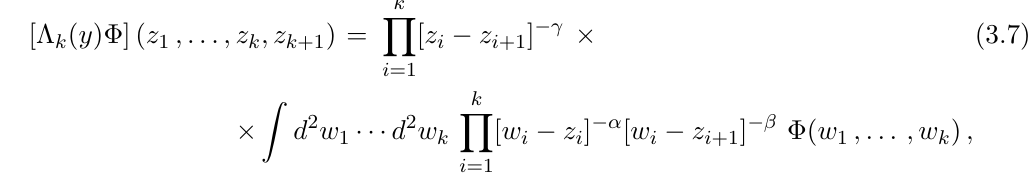
z 0 ): (1) The diagram j z 0 ) (cid:3) 3 ( y 2 z 0 ): (cid:11) 1 = 1 s y 1 , (cid:11) 2 = 1 s y 2 , j j (cid:0) (cid:0) (cid:0) (cid:0) 1. (3) Triangle-star transformations inside the right (cid:0) (cid:12) 1 upstairs (cid:0)